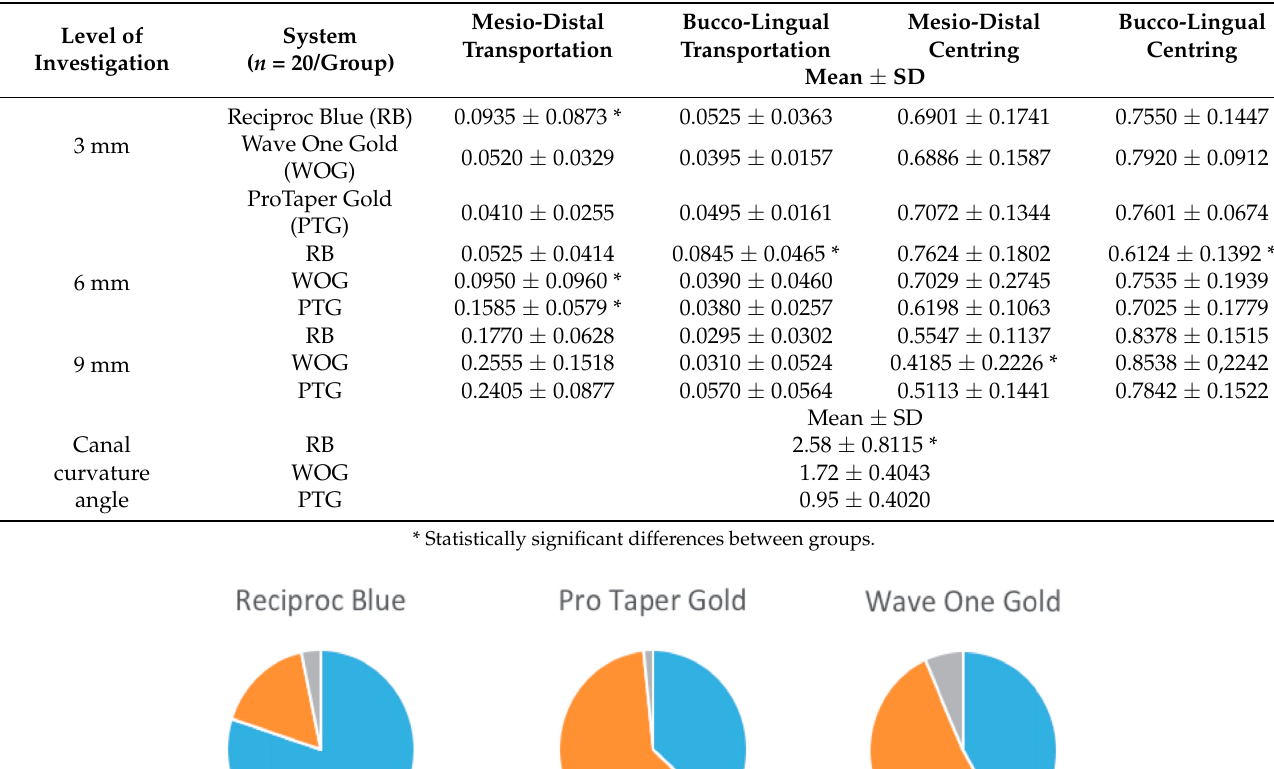
Table 1. The mean values (mm) and the standard deviation (SD) for the mesio-distal and bucco-lingual transportation and centring ability at the three considered levels, and the variation of the canal curvature angle ( ◦ ).